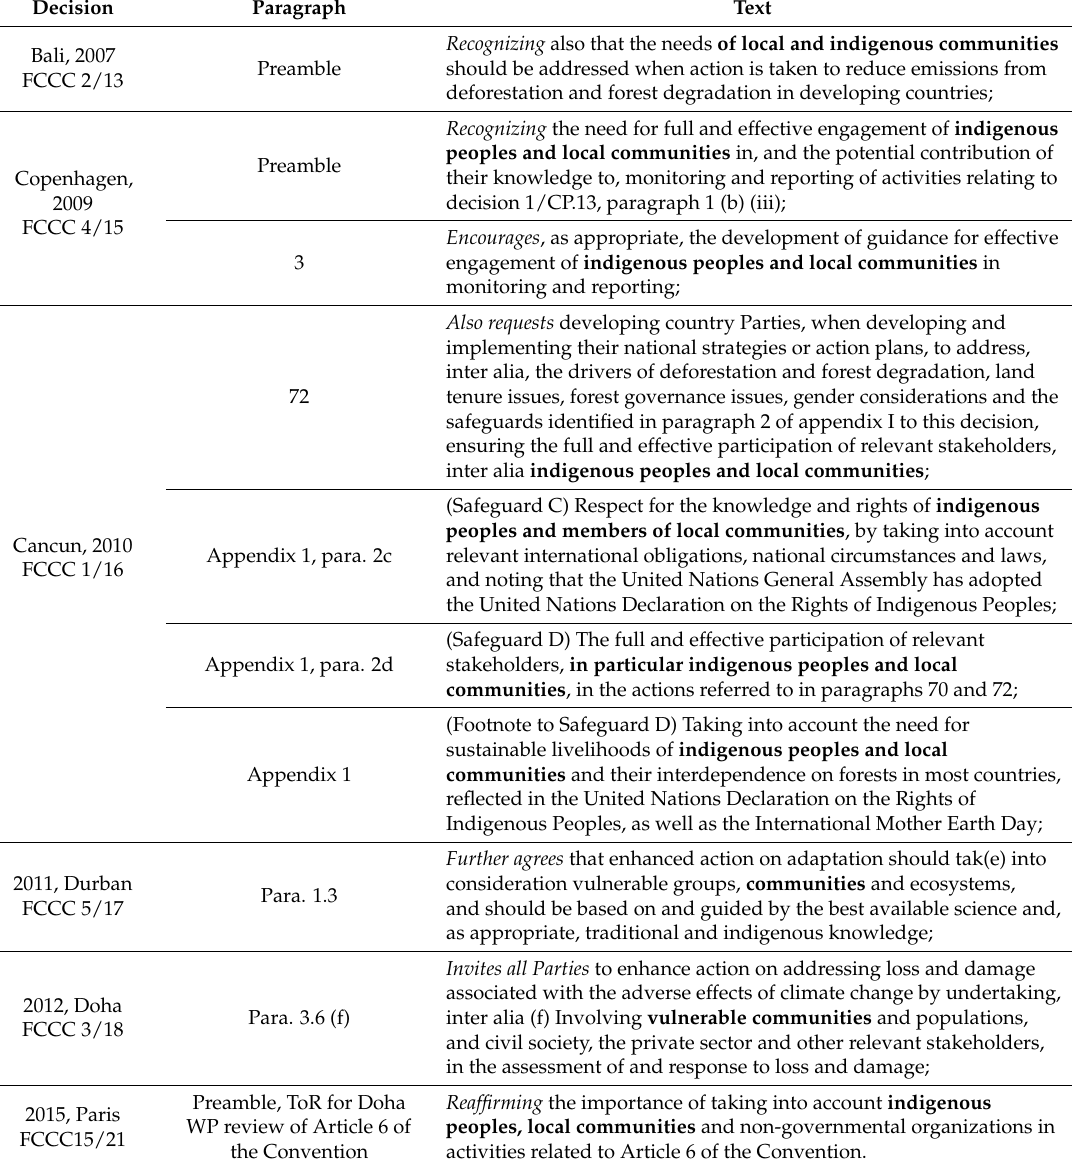
Table 1. References to communities and indigenous peoples in the United Nations Framework Convention on Climate Change (UNFCCC) decisions on Reduced Emissions from Deforestation and Forest Degradation